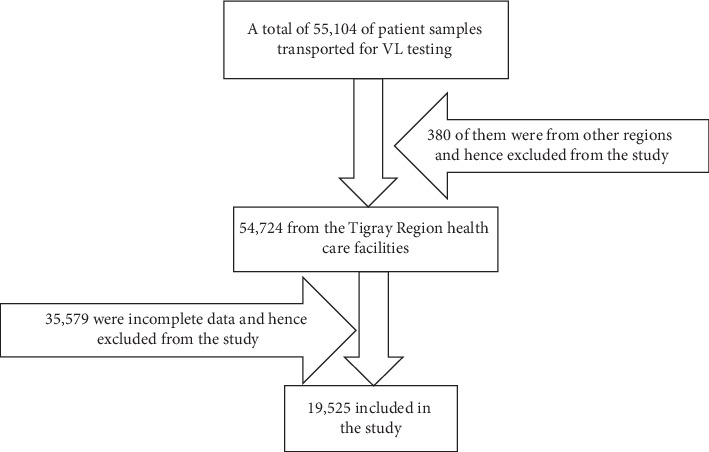
Diagrammatic presentation of the sampling procedures.